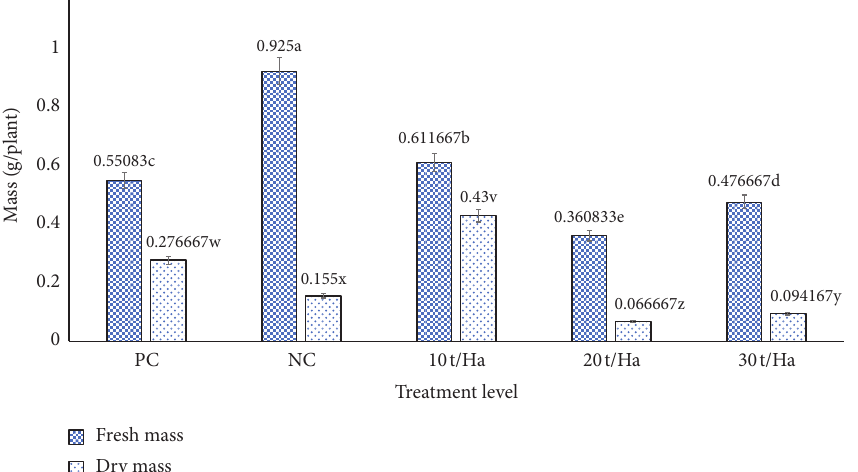
Figure 3: Below-ground fresh and dry mass. ∗ Means with different letters are significantly different at p < 0.05. PC � positive control. NC � negative control. t/Ha � spent mushroom rate per hectare.